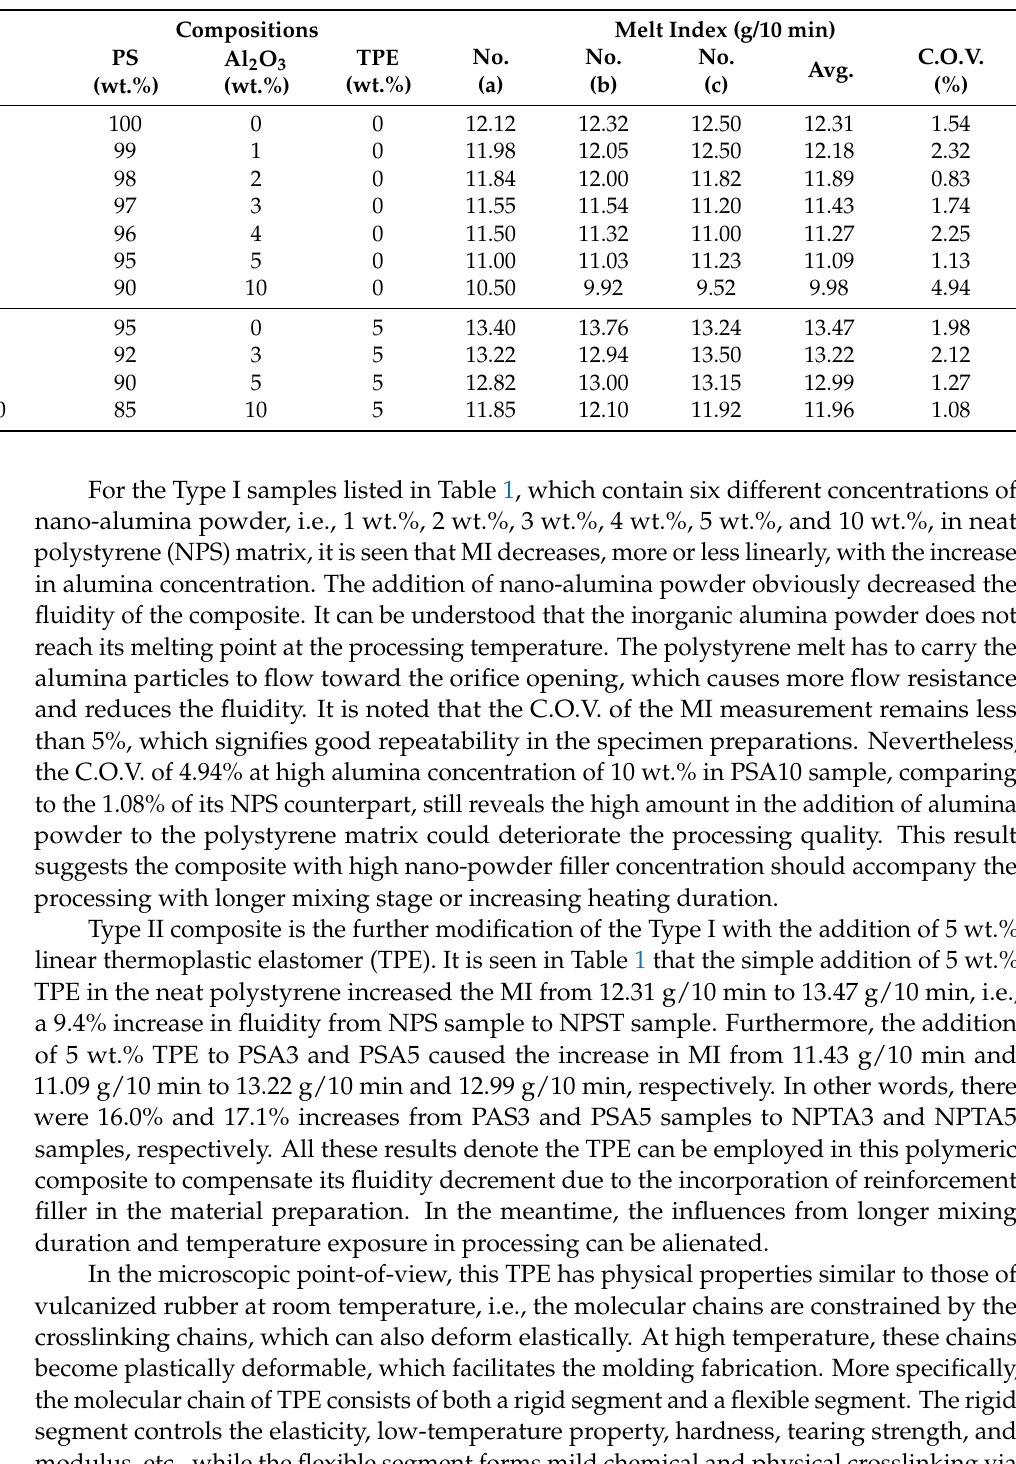
Table 1. The measured melt flow indices of the composite samples prepared with different